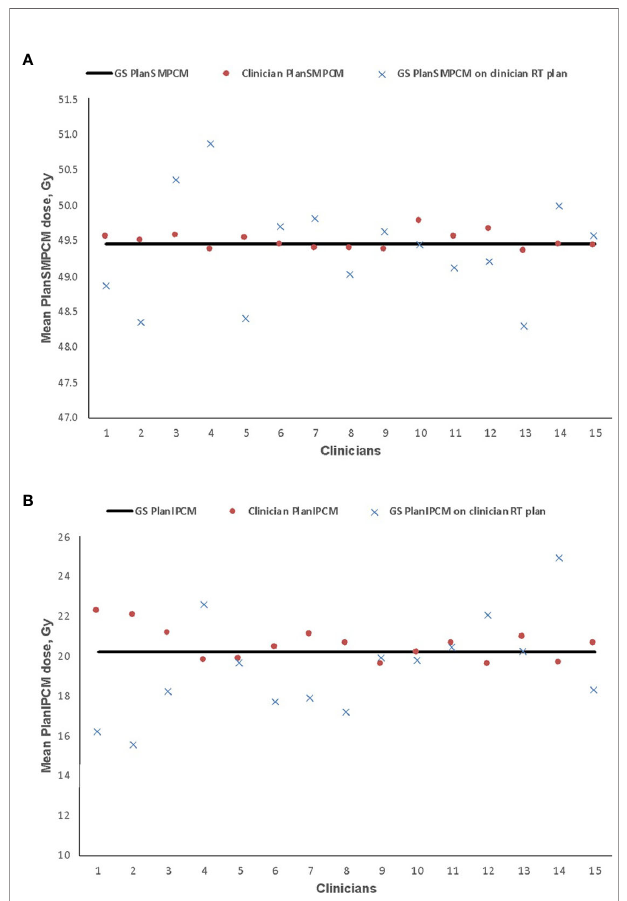
FIGURE 4 | Mean dose delivered to plan superior and middle pharyngeal constrictor muscle (PlanSMPCM, A ) and inferior PCM (PlanIPCM, B ) with clinician dysphagia-optimized intensity modulated therapy (Do-IMRT) plans, and the gold standard (GS) contour superimposed on the clinicians ’ Do-IMRT plan The horizontal line represents the mean dose delivered to the structures on the GS plan, based on GS contours.